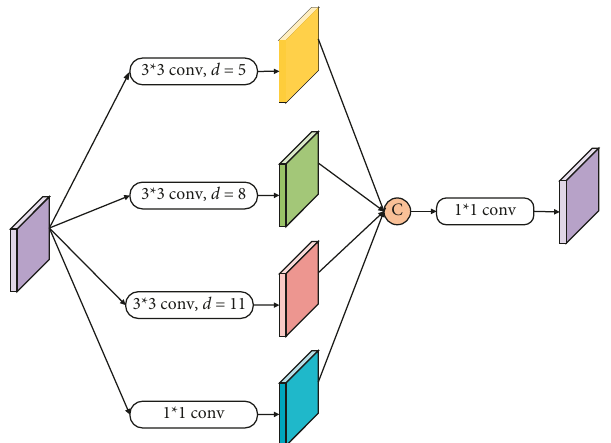
Figure 4: Enlarged receptive field